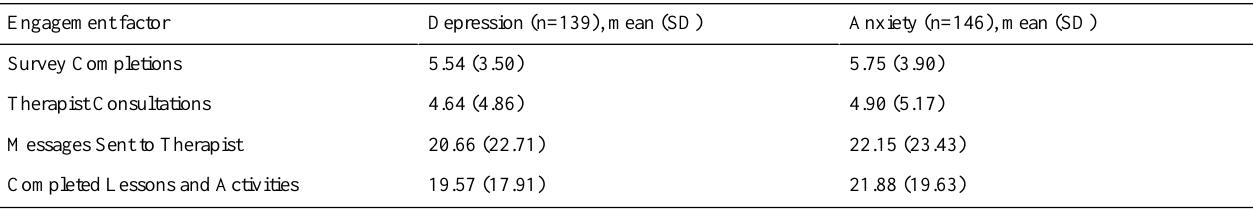
Table 2. Program engagement during the intensive phase of the program by condition.